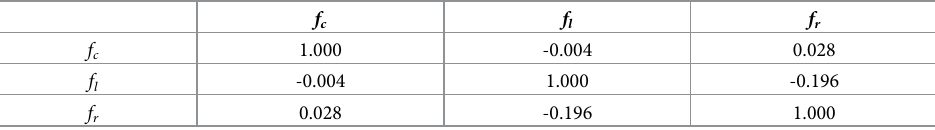
Table 5. Correlations of influencing factors.